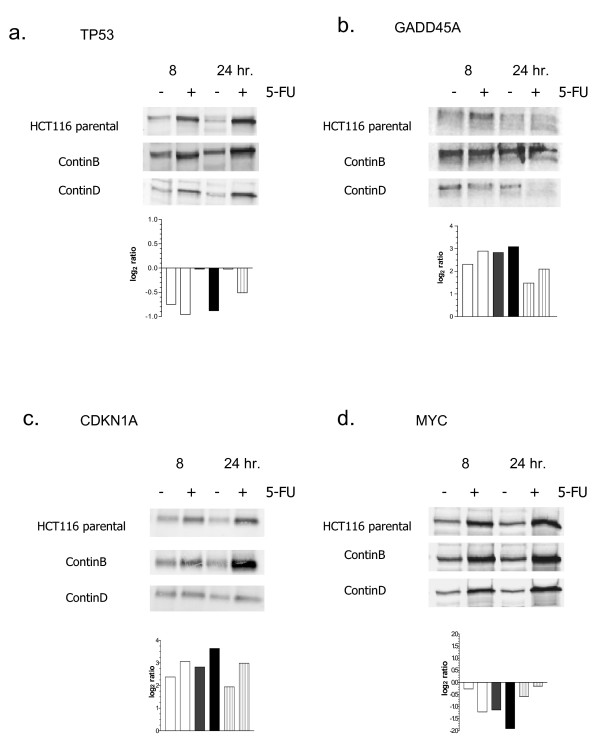
DNA damage response and cell cycle-regulatory protein and transcript levels in 5-FU-treated parental and resistant HCT116 cell lines: (a) p53 protein and TP53 transcript levels at 8 and 24 hours in 5-FU-treated HCT116 cell lines and their corresponding untreated controls; (b) GADD45A protein and transcript levels at 8 and 24 hours in 5-FU-treated HCT116 cell lines and their corresponding untreated controls; (c) CDKN1A protein and transcript levels at 8 and 24 hours in 5-FU-treated HCT116 cell lines and corresponding untreated controls; (d) MYC protein and transcript levels at 8 and 24 hours in 5-FU-treated HCT116 cell lines and corresponding untreated controls. For the bar charts that present gene expression levels, colorless bars depict the parental cell line, black bars the ContinB cell line, and vertically-striped bars the ContinD cell line.